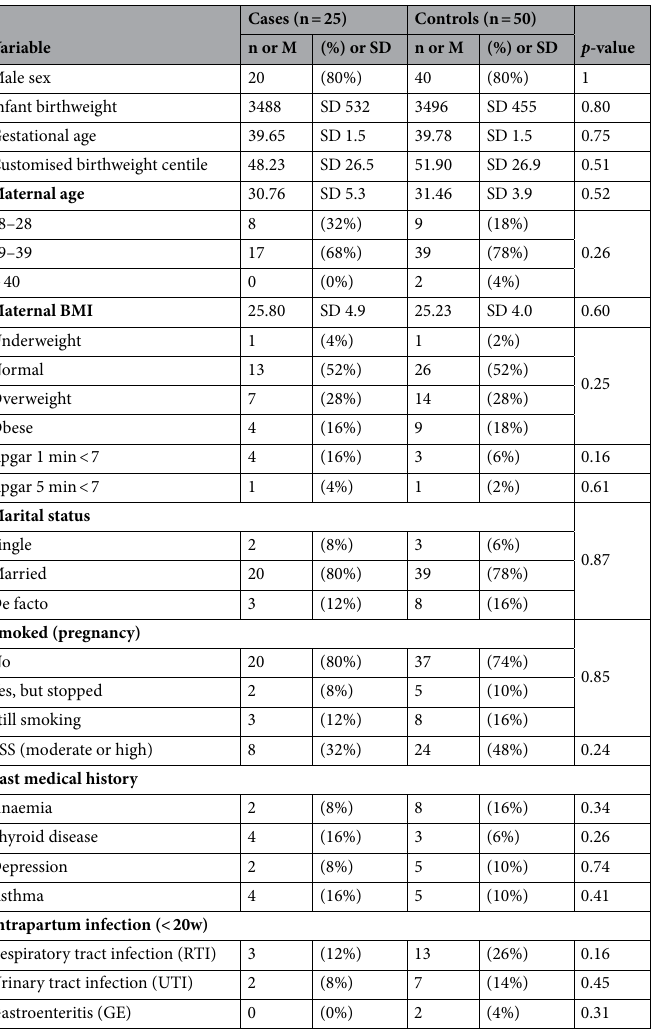
Table 2. Demographic characteristic of study participants. In this table, we calculated all p -values using the Pearson Chi square for categorical data, and independent samples t-test or Mann–Whitney U-test where appropriate for continuous variables depending on the normality of the distribution. There are no significant differences demonstrated between the groups in any of the variables listed. Cases and controls are well matched with little variance between the key matching variables, infant sex, gestational age and birthweight. Data are presented as either the mean (SD) with continuous variables or n (percentage) with categorical